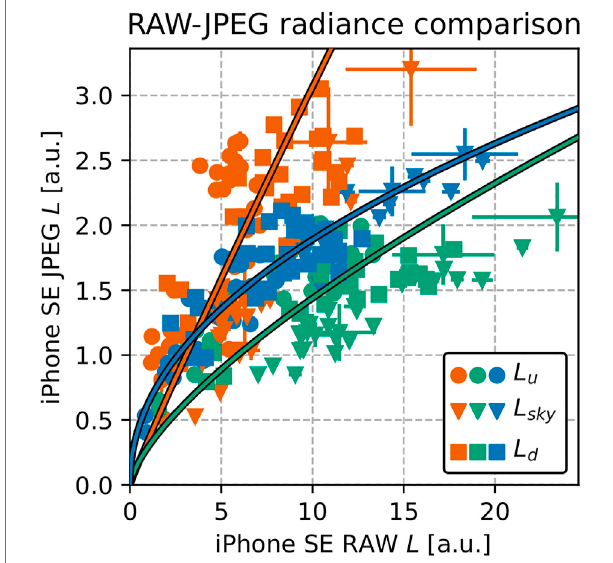
FIGURE 13 | Comparison between RAW- and JPEG-based iPhone SE radiance measurements. The axes are in different units due to differences in exposure settings and normalization. The RGB channels are shown in their respective colors, with different symbolsfor L u , L sky , and L d . The colored lines show the best- fi tting power law for each